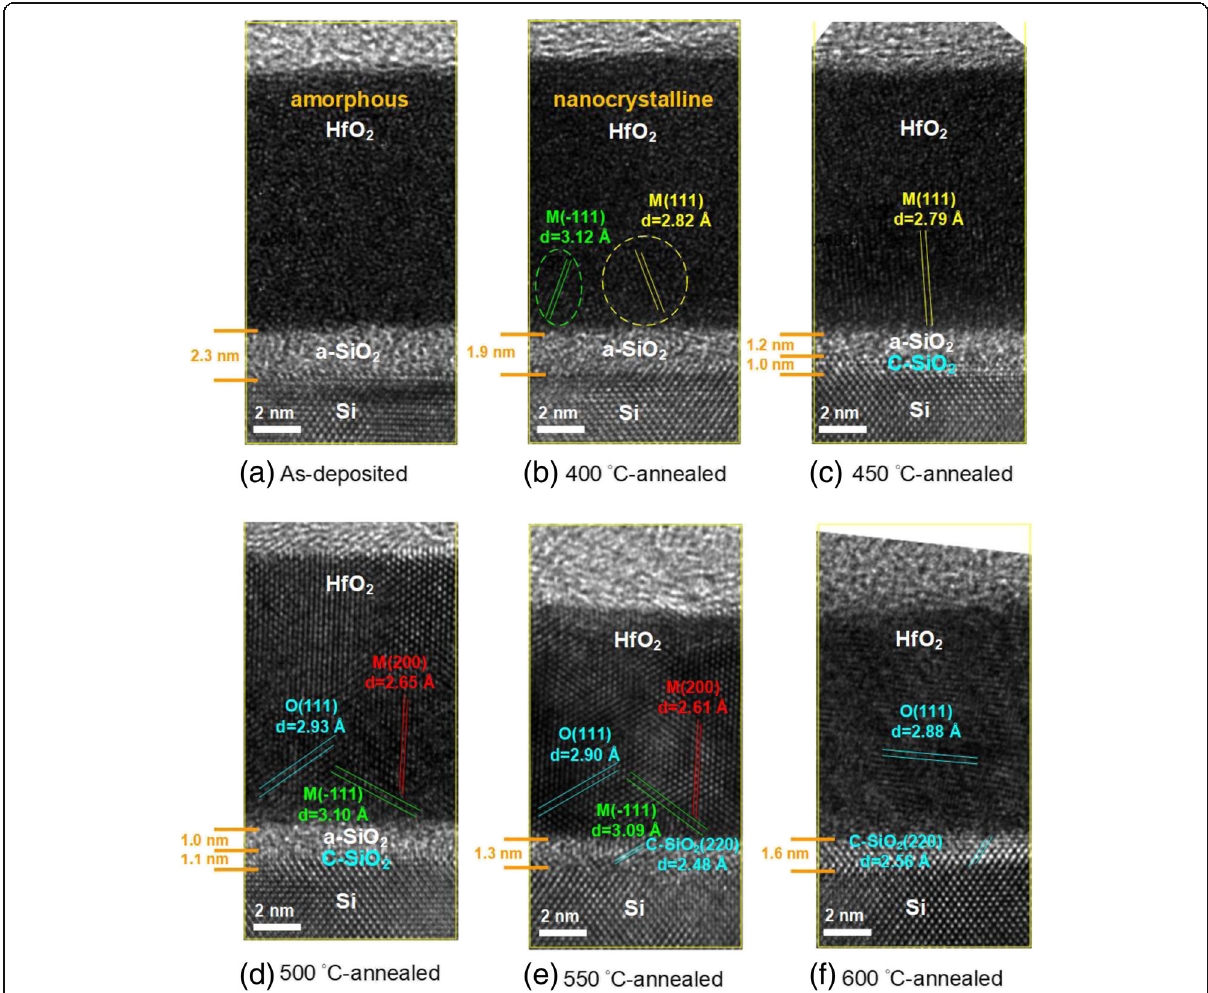
Fig. 4 Cross-sectional TEM images of a as-deposited, b 400 °C-annealed, c 450 °C-annealed, d 500 °C-annealed, e 550 °C-annealed, and f 600 °C-annealed